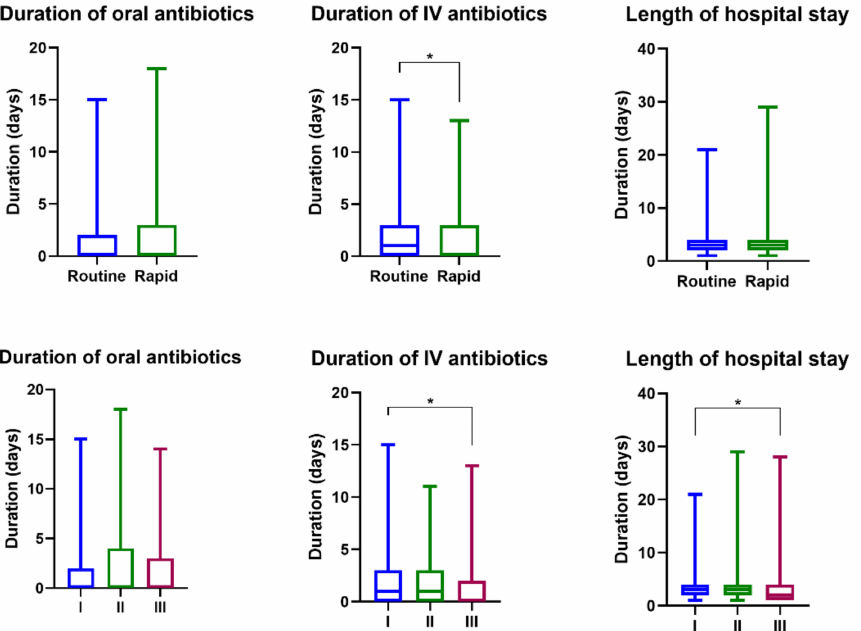
Figure 4. Comparison of antibiotic use and hospital stay according to the mPCR test and period; * means two values were statistically significant ( p <